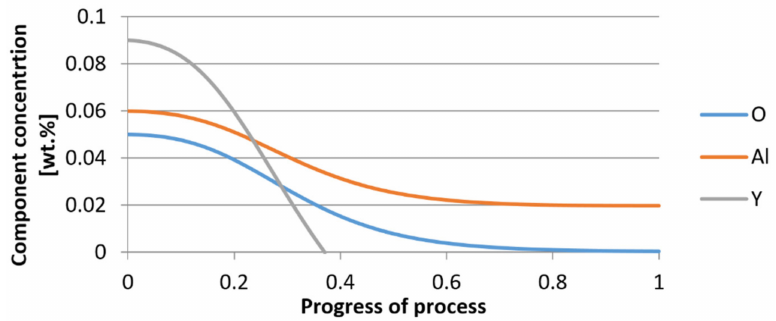
Figure 19. Change of components concentration during the growth of a bi-component nucleus (Al 2 O 3 –Y 2 O 3 ) in steel 1 (for r 0 = 5 µ